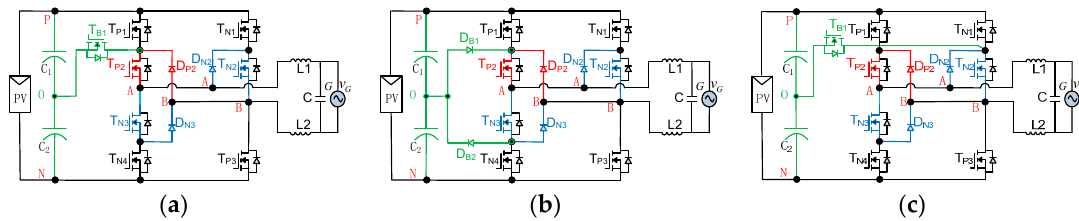
Figure 11. Indirect Connection NPC topologies from M = 3, N = 4 or M = 4, N = 3. ( a ) R9S1-1 (new); ( b ) R9S1-2 (new); ( c ) R10S1 (new).